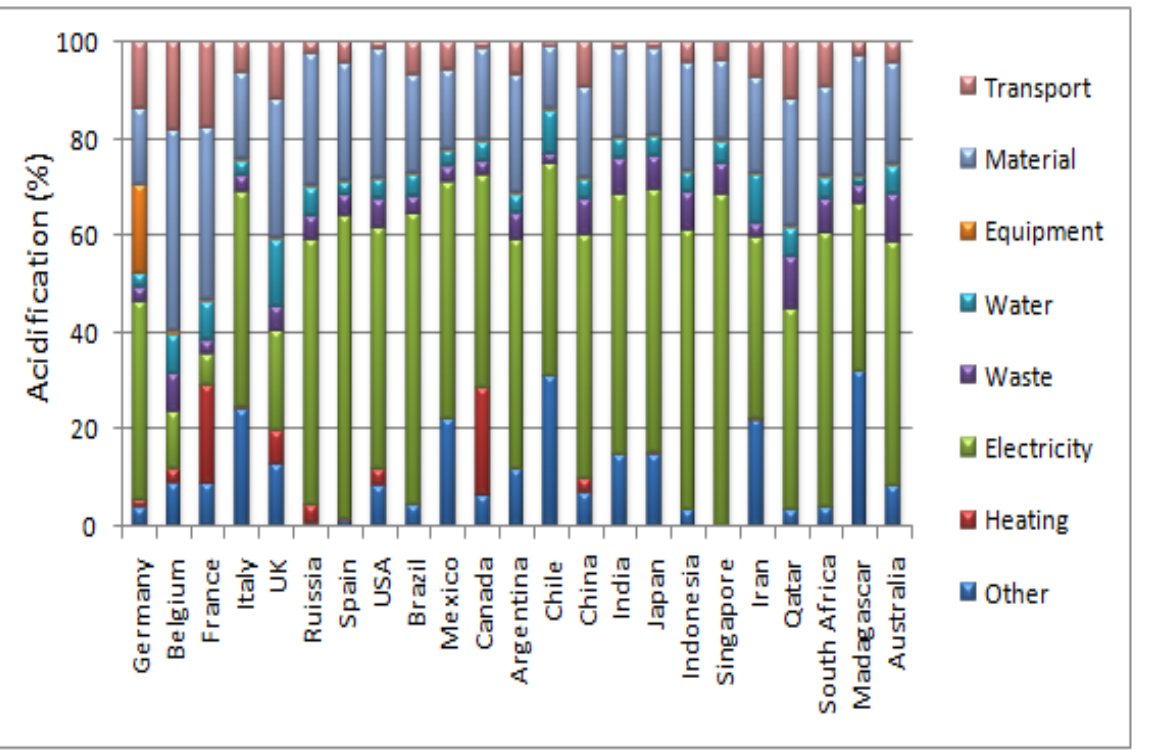
Figure 7. Frequency (%) of the different environmental components in the generation of the acidifi- cation for some countries located in the five continents of the world.